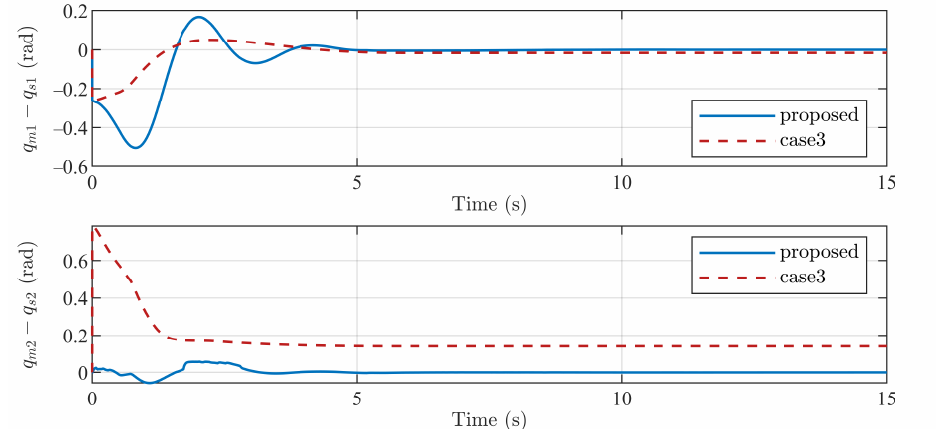
Figure 18. Comparisons of task space tracking errors based on the proposed method and the method in Case